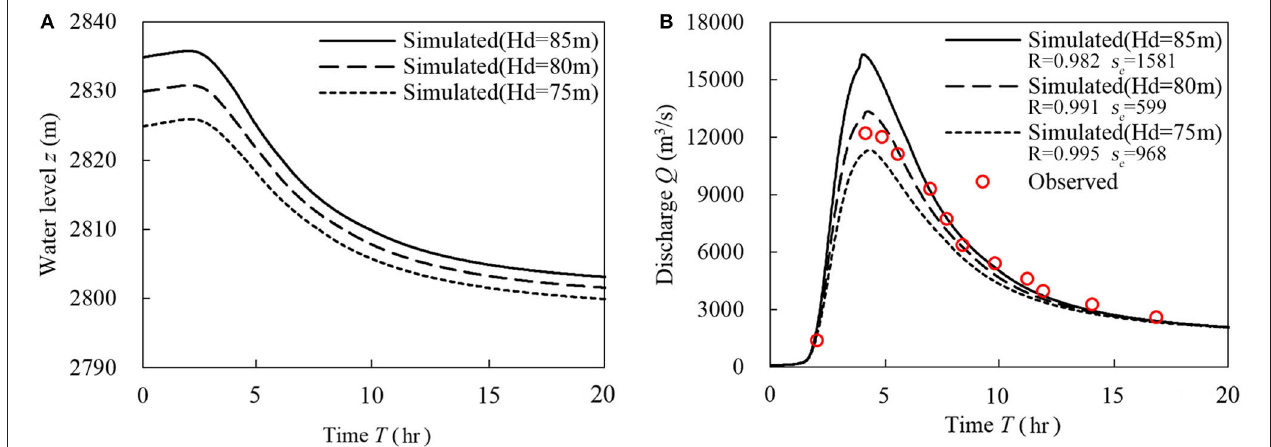
FIGURE 6 | The breach process of the “October 29” dammed lake. (A) Time series of the simulated water level at the inlet of spillway; (B) simulated flow hydrograph compared with the measurements. The Pearson correlation coefficient R under different dam heights vary in the range of 0.982–0.995, and the values of root mean square error RMSE ( s e ) vary in the range of 599–1,581.